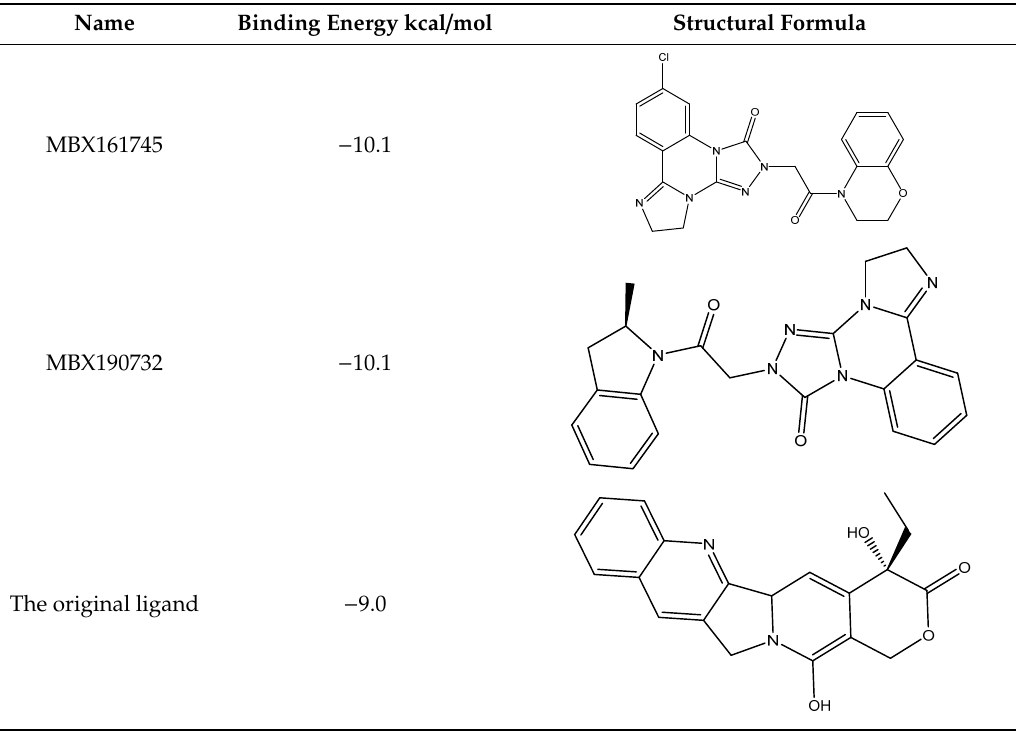
Figure 8. The conformations and the interactions between receptor protein and some typical ligands.